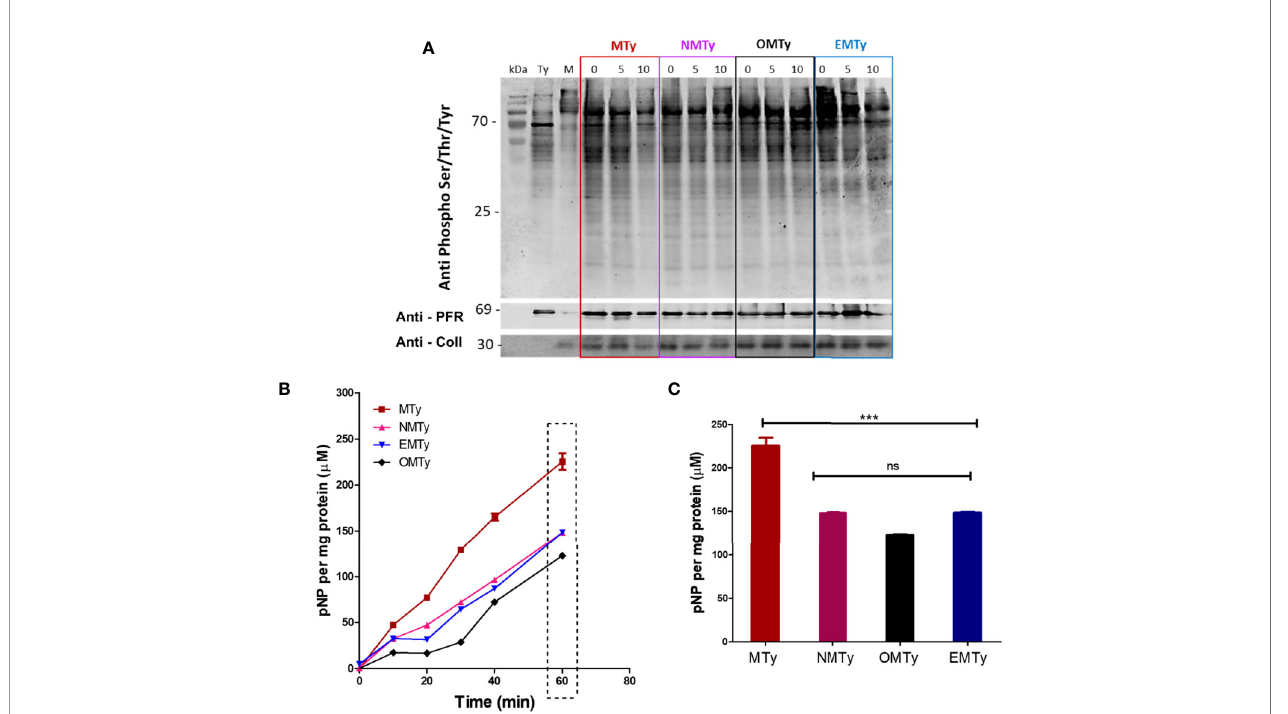
FIGURE 5 | Phosphoprotein pro fi le (A) and p-nitrophenyl phosphatase activity (B, C) from tissue culture-derived trypomastigotes upon interaction with ECM. Ty (trypomastigotes), MTy (+40 µg of ECM), NMTy (+40 µg of ECM and 4 µM Nifedipine), OMTy (+40 µg of ECM and 10 nM Okadaic acid), EMTy (+40 µg of ECM and 1 mM EGTA). (A) Immunoblot showing the phosphorylated protein pro fi le of the samples incubated under the described conditions for different periods of time (0, 5, or 10 min). M corresponds to the control of the ECM (0.4 µg per lane); Anti-ColI (Collagen I) antibody indicates the presence of ECM in the sample (control); Anti-PFR (Para fl agellar Rod Protein) monoclonal antibody [control for the normalization of parasites loading (1 x 10 6 parasites/lane)]. (B) Total p-nitro phosphatase activity of the MTy samples incubated with the drugs for 10 min. The production of pNP (p-Nitrophenol) was measured at different periods of time as indicated. The graph is representative of three independent experiments. (C) Bars representation of the square present in (B) , statistical signi fi cance (One-way ANOVA) P < 0.05. ***P < 0.001; ns, no signi fi